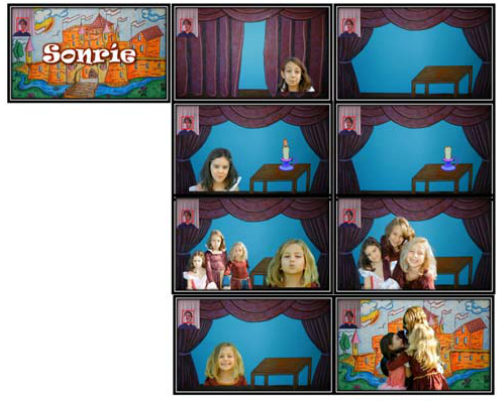
Figure 10. Interaction screens with different games to motivate children.